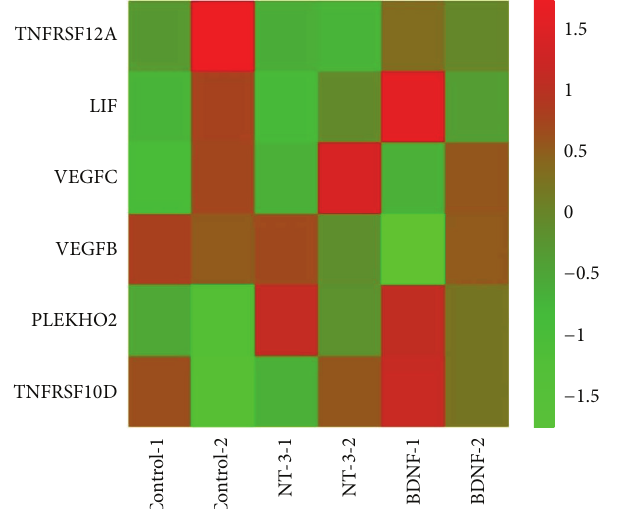
Figure 9: Heat map showing genes related to cytokine-cytokine receptor interaction with RPKM values of more than 5 in three